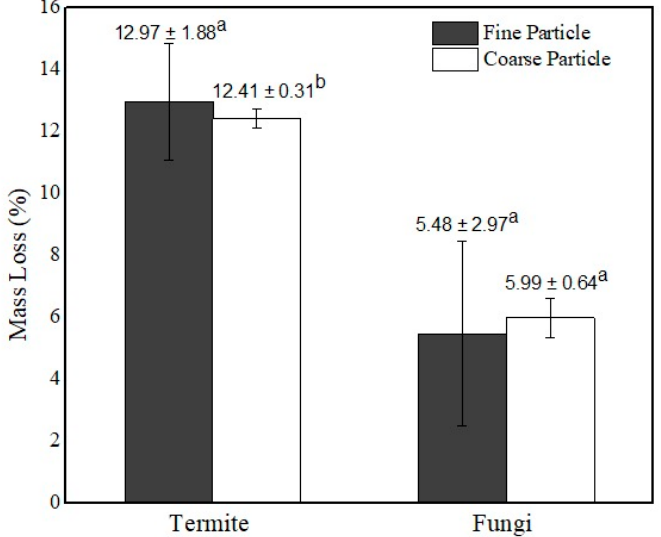
Figure 7. Mass loss of D. asper particleboards caused by subterranean termites ( C. curvignathus ) and white-rot fungus ( S. commune ). Values followed by different lowercase letters are statistically different at p < 0.05.